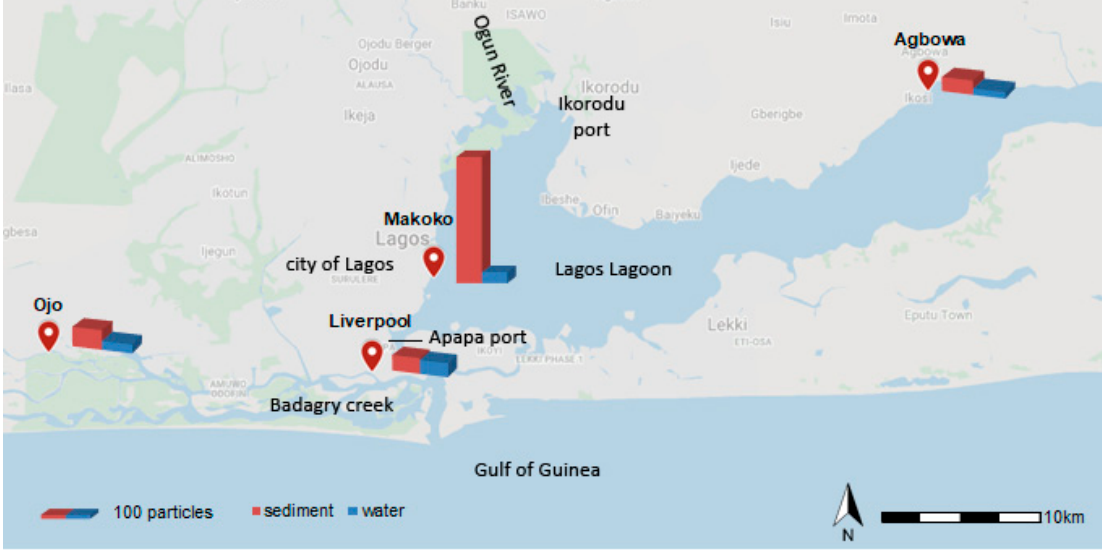
Figure 2. Abundance of tentative microplastics (MPs) in sediment (per kg) and water (per L at the four sampling sites (source: Google Maps, 2020).